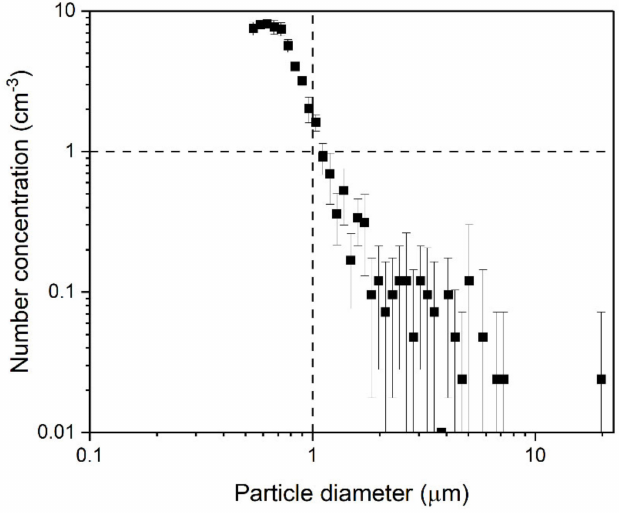
Figure 2. Background number concentration for 0.5–20 µ m